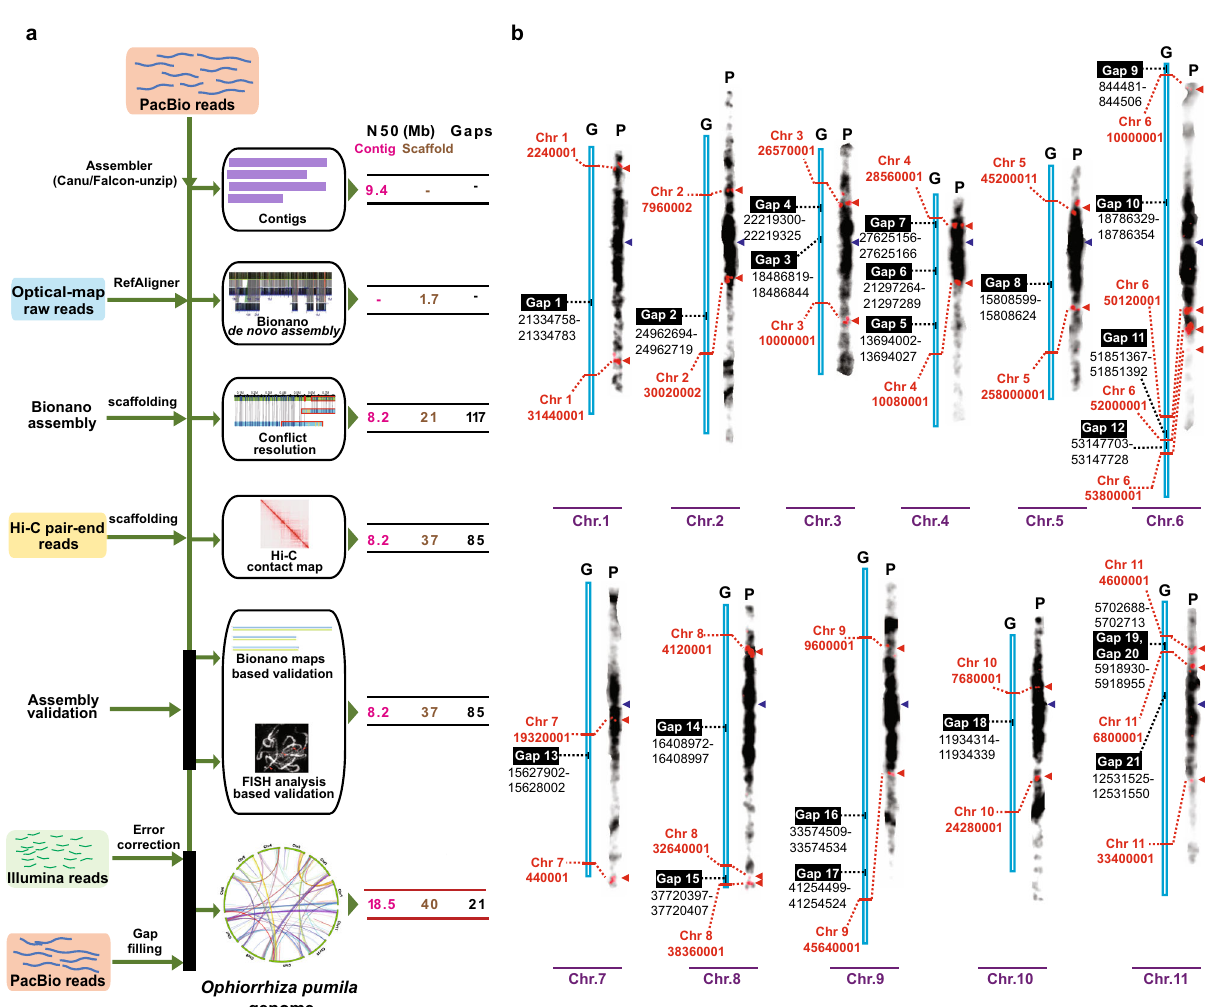
Fig. 1 Multistage assembly validation to achieve chromosome-level genome assembly for a high repeat content plant genome. a The hierarchical genome assembly and assembly validation pipeline, and the improvement of assembly contiguity in terms of contig N50, scaffold N50, and assembly gaps of O. pumila genome. The assembly schema consistently corrects genome assembly from the point of contig-level assembly to the scaffold-level assembly, using orthogonal evidence and experimental validations. b Fluorescence in situ hybridization (FISH)-based validation of chromosome arms and orientation of scaffolds at the assembly gaps of Ophiorrhiza genome. The red triangle represents the site of FISH probe signal identi fi ed for a given chromosome, and the dotted line corresponds to the position at the scaffold. The purple colored triangle represents putative centromere at the pachytene chromosome, representing densely packed genomic segment, and hence darkly stained. The FISH experiment was repeated twice, and for each experiment, at least ten slides for each chromosome were observed and veri fi ed for signals as shown in b . G assembled chromosome, P pachytene chromosome with a FISH chromosomal arms (Supplementary Fig. 6). We used FISH evi- dence to correct contig orientation within assigned scaffolds for chromosome 2. The chromosome sizes estimated using FISH analysis were consistent with the corresponding assembled chromosome sizes for the O. pumila genome (Supplementary Fig. 7 and Supplementary Table 1). The accuracy of the fi nalized reference and phased genome assemblies was also supported by Bionano optical map data, Bionano de novo assembly, and Hi-C chromosomal contact matrix (Fig. 2, and Supplementary Figs. 8 and 9).